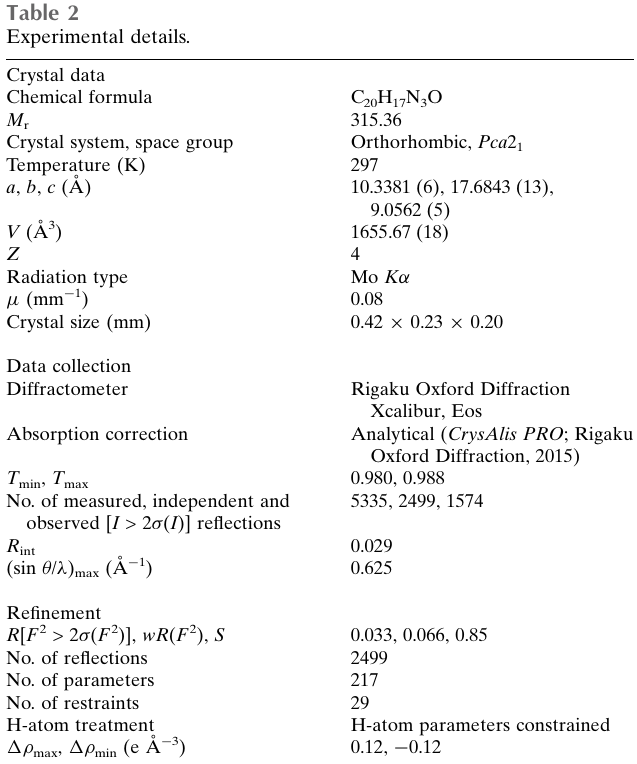
Table 2 Experimental details.